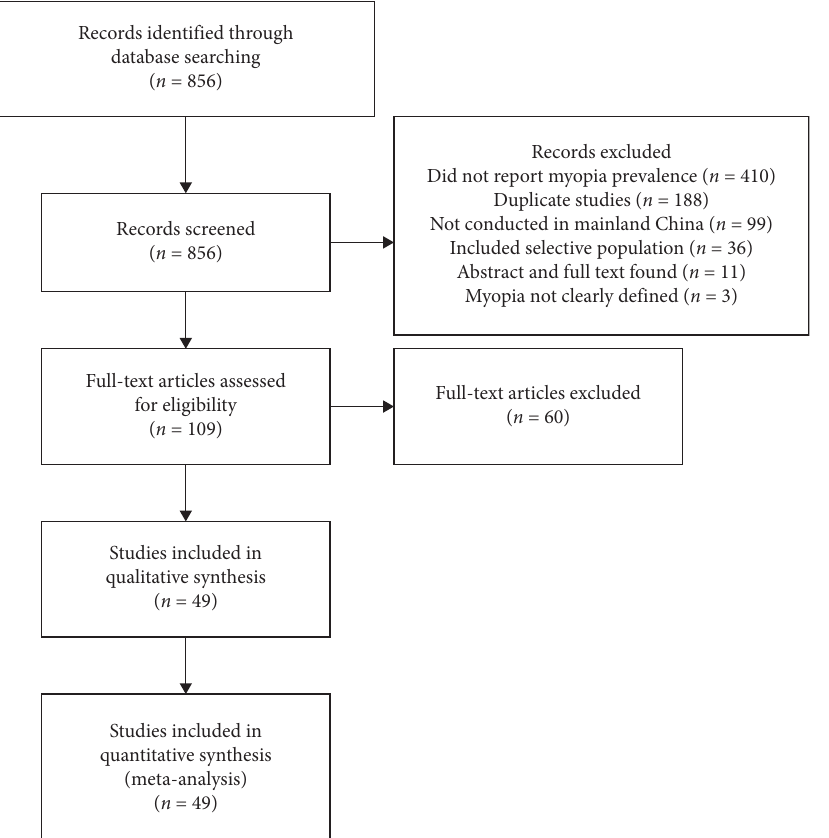
Figure 1: Flow diagram of the study selection